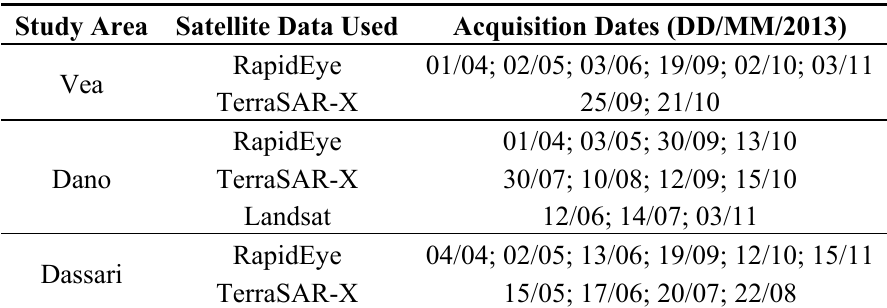
Table 1. Satellite imagery used and their acquisition